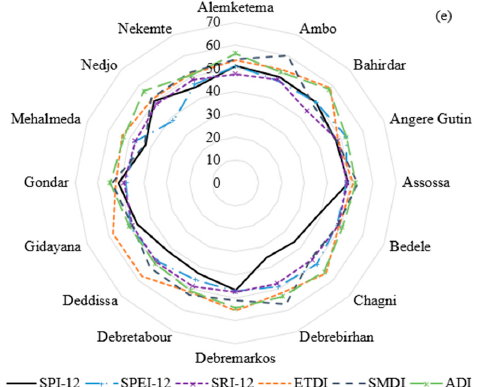
Figure 3. Comparison of SPI, SPEI, and SRI with ETDI, SMDI, and ADI at 1-month ( a ), 3-month ( b ), 6-month ( c ), 9-month ( d ), and 12-month ( e ) time scales based on percentage of drought months at the locations of the selected meteorological stations. A line is used to connect values of the same variable at distinct locations to increase the visibility of the points in this figure. .